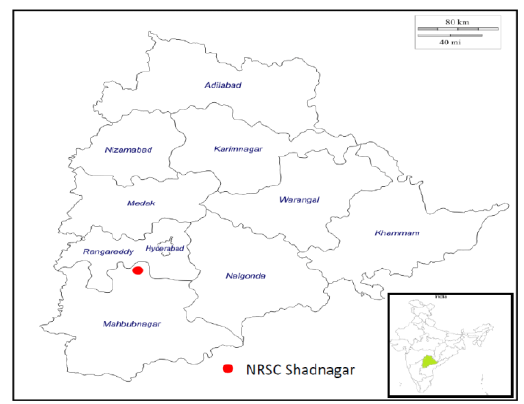
Figure 1. Location of NRSC Shadnagar campus on state map of